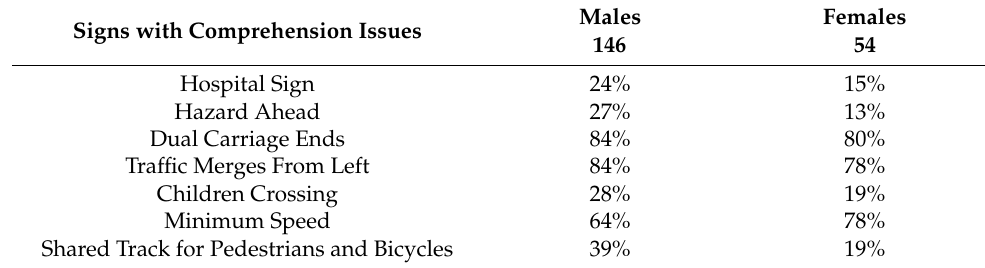
Table 8. Percentage of the seven road sign comprehension failures by